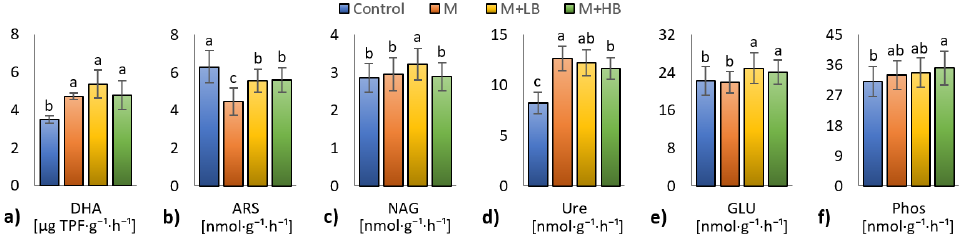
Figure 3. Mean values of soil enzyme activities. ( a ) DHA = dehydrogenase activity, ( b ) ARS = arylsulfatase activity, ( c ) NAG = N -acetyl- β - D -glucosaminidase activity, ( d ) Ure = urease activity, ( e ) GLU = β -glucosidase activity, ( f ) Phos = phosphatase activity. Average values of independent replicates ( n = 3), error bars = standard deviation; the different letters express the statistical differences at significance level p ≤ 0.05.